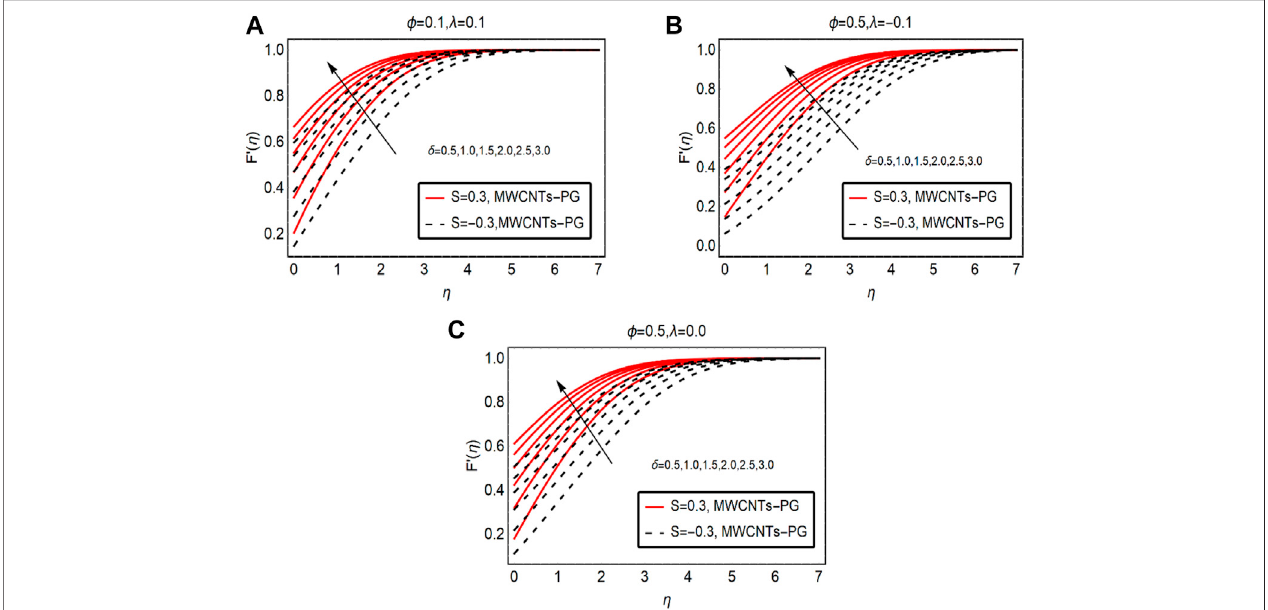
FIGURE 2 | F ′ ( η ) against δ (A) λ > 0 and (B) λ < 0 and (C) λ (cid:2)